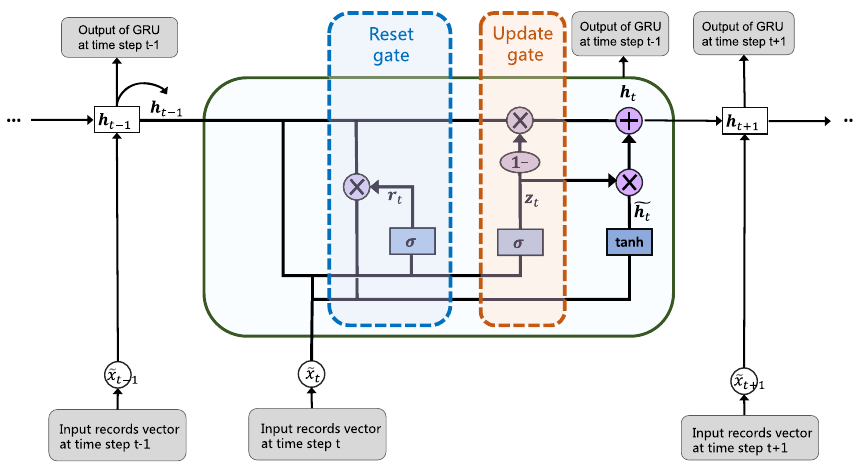
Fig. 5 The structure of GRU at time